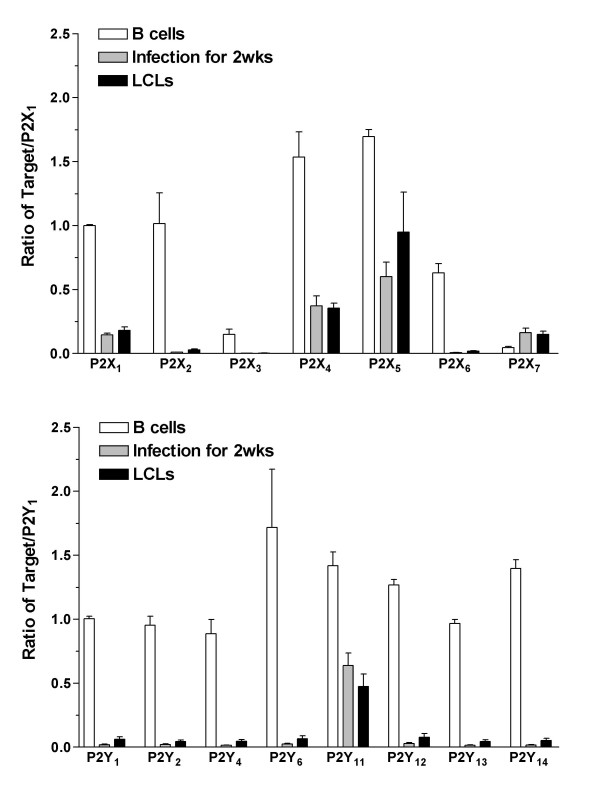
Comparison of relative P2 receptor expression in B cells and LCLs. The relative expression of the P2X receptor gene (upper) and P2Y receptor gene (lower) in B cells, EBV-infected B cells for 2 weeks, and LCLs are presented (n = 4). The expression was normalized to GAPDH. P2X receptors were calibrated by P2X1 of B cells and P2Y receptors were calibrated by P2Y1 of B cells. Data are the mean ± SEM.